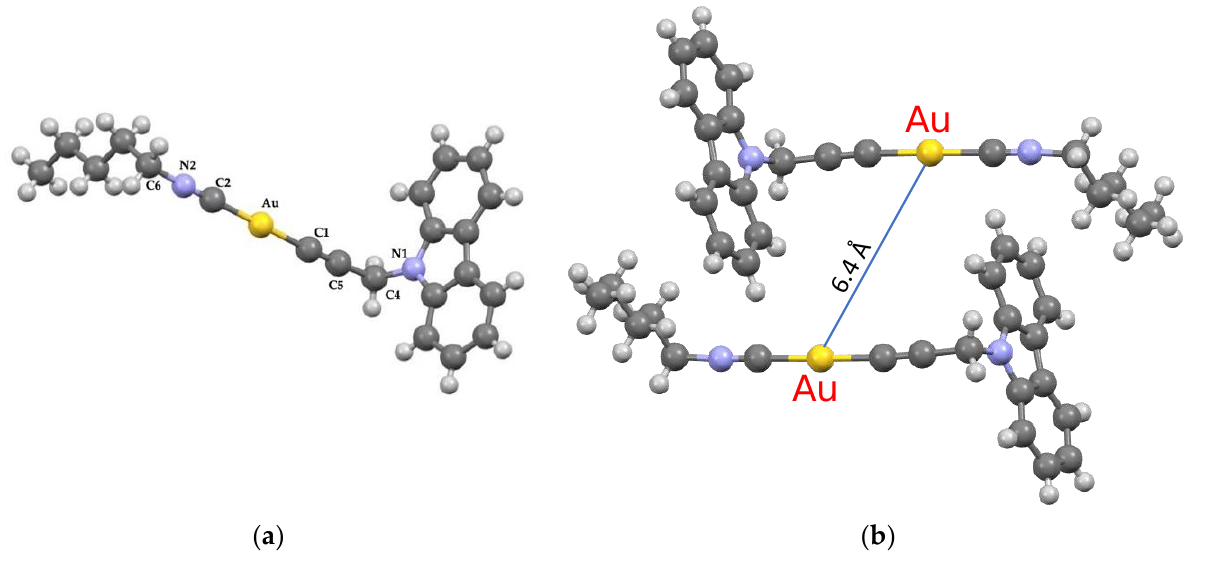
Figure 2. Molecular structure ( a ) and molecular packing structure ( b ) of complex Cbz-H determined via single-crystal X-ray diffraction at rt (gray, C; blue, N; yellow, Au; white, H).